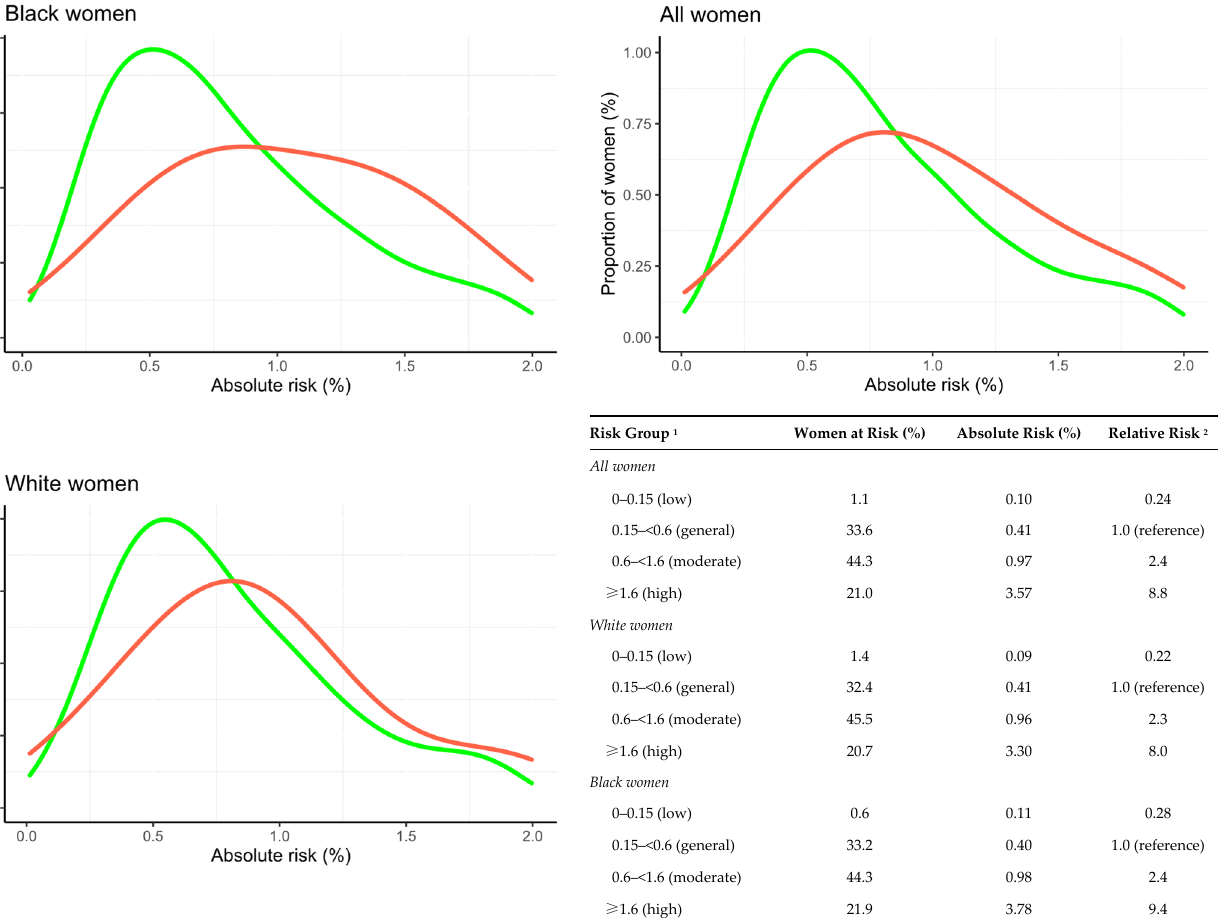
Figure 2. Frequency distribution of AI absolute 2-year risk scores for developing breast cancer in cases (red) and controls (green). Distributions presented for the entire dataset and in racial sub- groups. 1 Cut-offs for general, moderate, and high-risk groups are based on the NICE guidelines for 10-year risk in age group 40–50 (<3%, 3–8%, >8%) divided by 5. We added a fourth low-risk group with the absolute risk cut-off 0.15. 2 The relative risk was calculated as ratios of average risks in each absolute risk category. High-risk women in the full cohort had a 37-fold higher risk compared with women at low risk. The corresponding numbers for White and Black women were 36-fold and 34- fold. NICE: National Institute of Health and Care Excellence